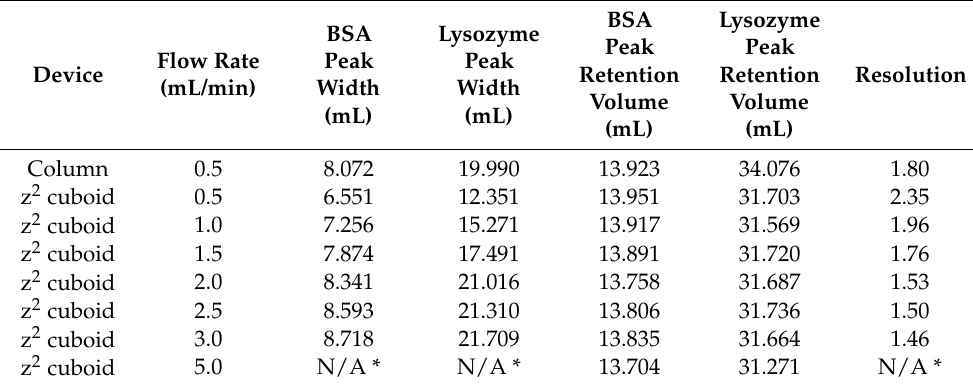
Table 2. Resolution in BSA–lysozyme separation using Sephacryl S-200 HR medium packed 24 mL Tricorn GL 10/300 column and 24 mL z 2 cuboid SEC device (mobile phase: phosphate-buffered saline, pH 7.4; loop: 2 mL; feed: 5 mg/mL BSA + 2.5 mg/mL lysozyme).